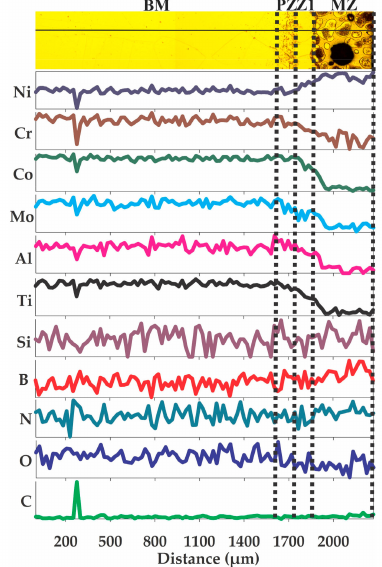
Figure 13. Linear profile of the chemical composition on a drop-sample of Ni-Sol-Wasp. Data obtained by the EDS